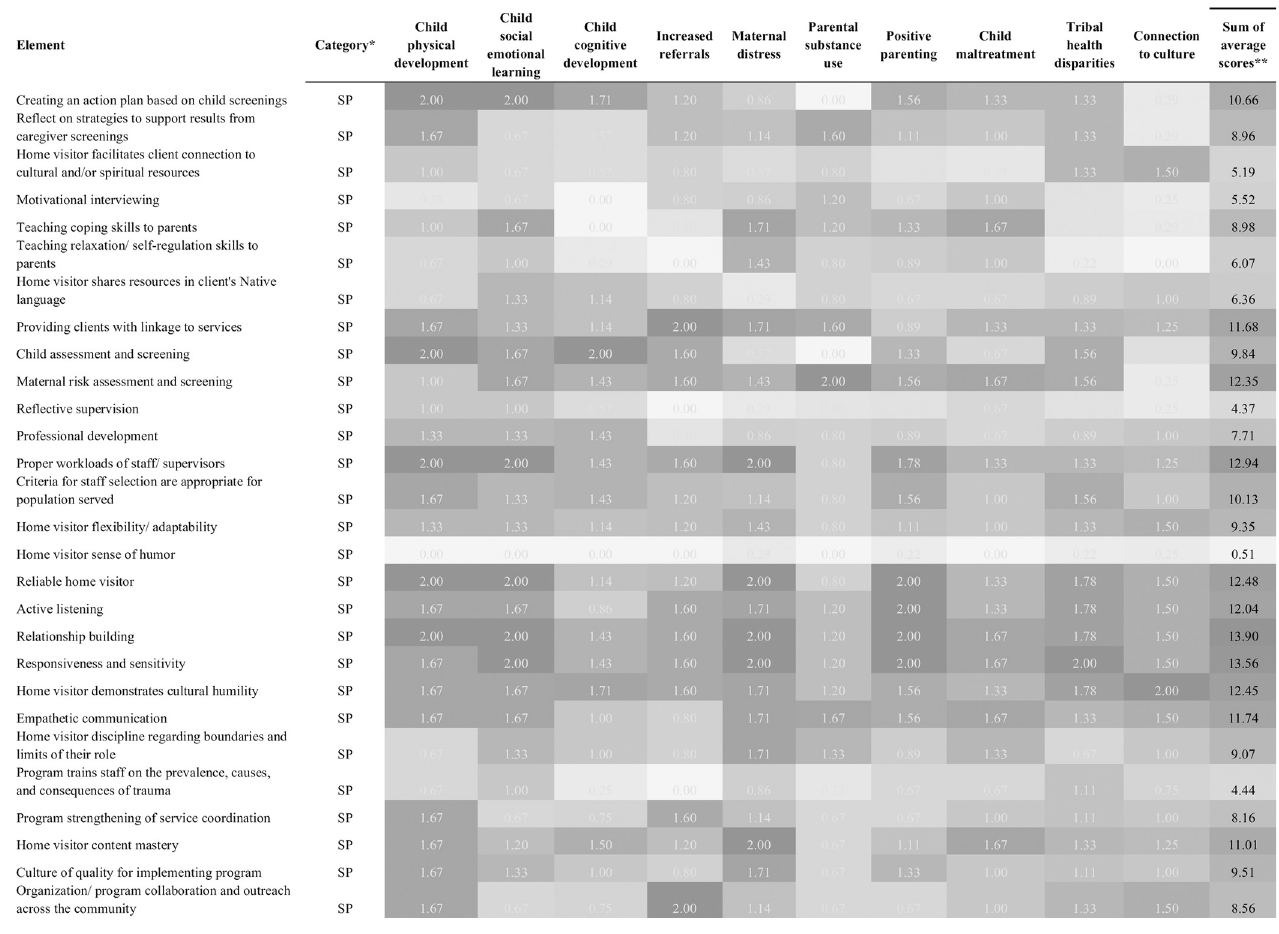
Fig 3. Heatmap of SPEs and BCTs and their relative importance across outcome domains. https://doi.org/10.1371/journal.pone.0275981.g003 Table 2. SPEs and behavioral change techniques classified by 50% or more respondents as essential by domain. Outcome